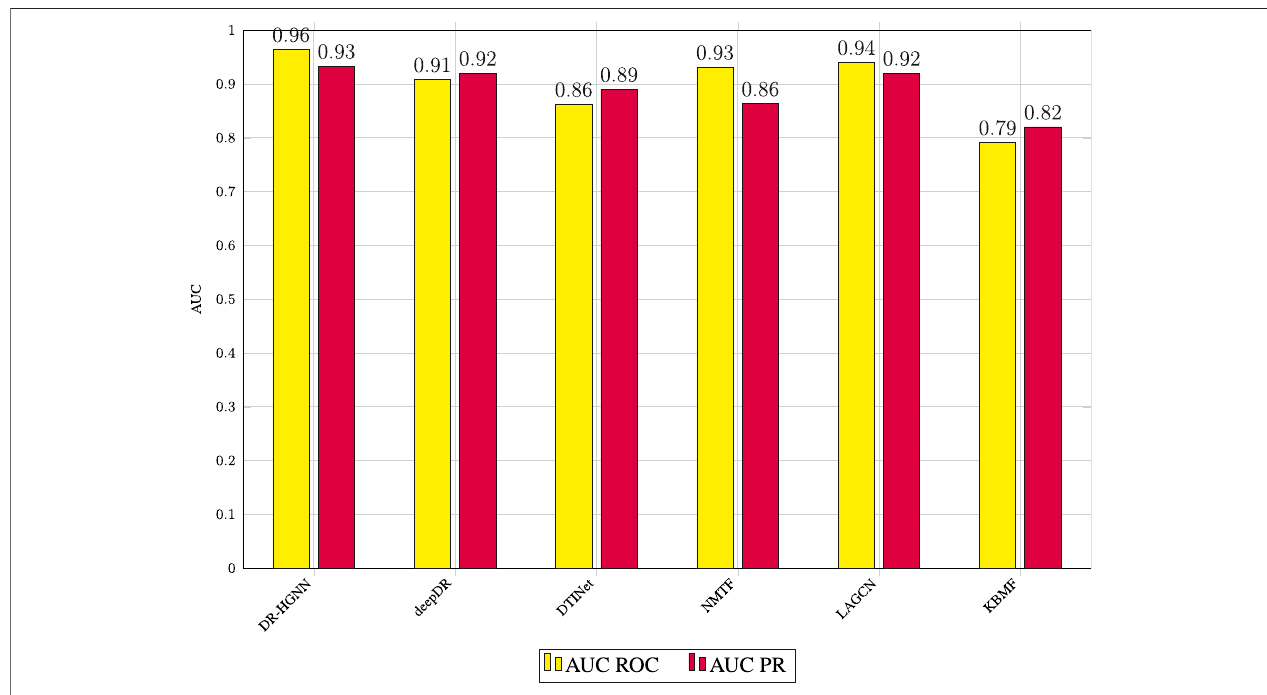
FIGURE 2 | AUC ROC and AUC PR values of prediction results obtained by applying DR-HGNN and other reported methods in 5-fold cross-validation.